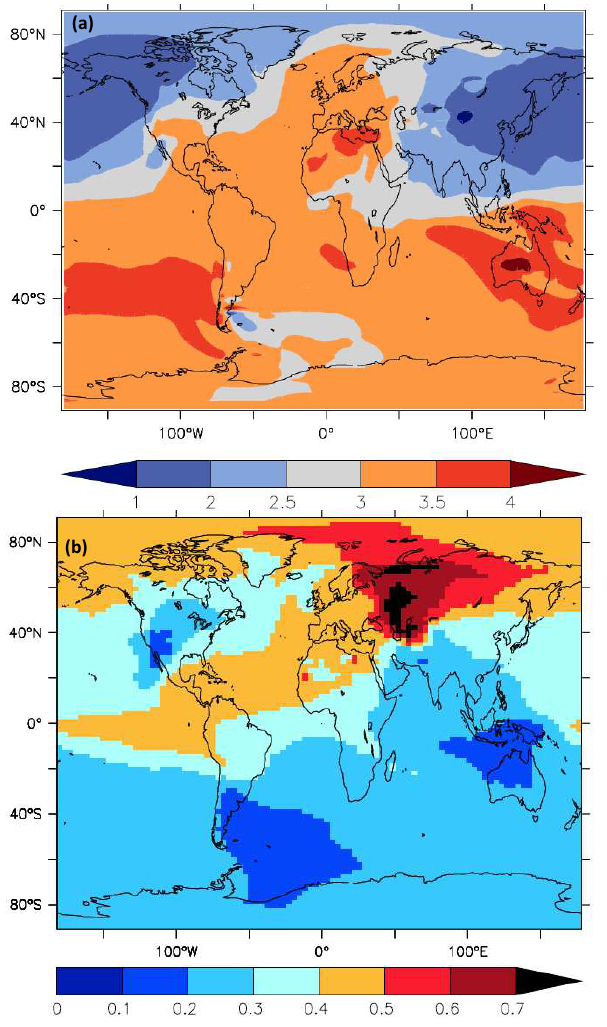
Fig. 14. (a) Mass in percent of hematite plus goethite and (b) elative mass ratio of hematite to hematite plus goethite.